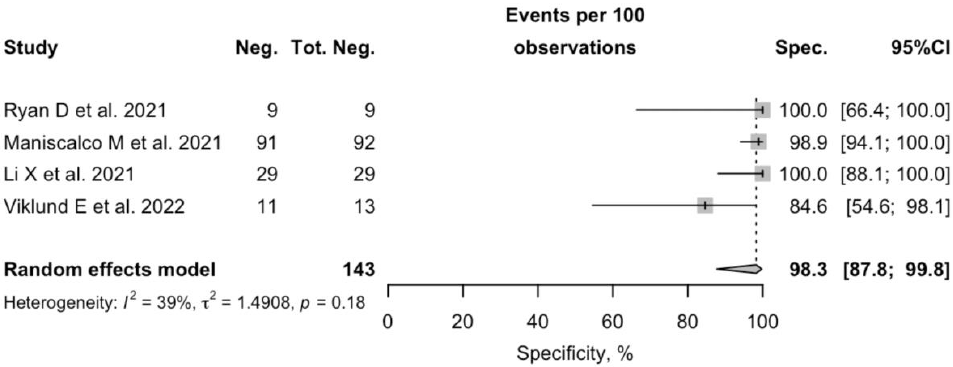
Figure 3. A forest plot representing the estimated specificity of SARS-CoV-2 Real-Time Quantitative Polymerase Chain Reaction (RT-qPCR) performed on specimens of exhaled breath condensate. Pooled specificity was 98.3% (95%CI 87.8–99.8), with moderate heterogeneity (I 2 39.0, p = 0.178) [4,14,17,18].